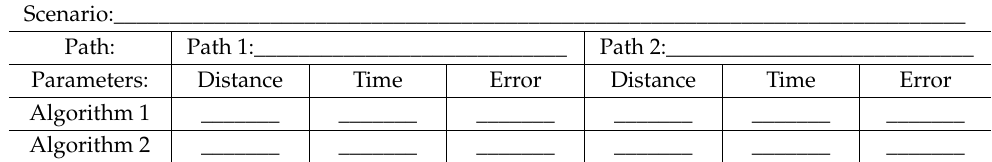
Table 2. Example of sheet report for results obtained.